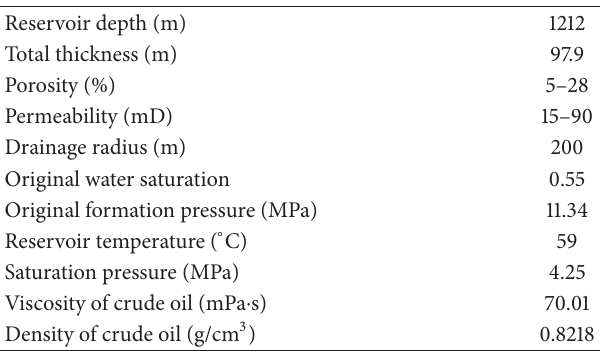
Table 3: Characteristic parameters of the reservoir (at a reservoir temperature of 59 ∘